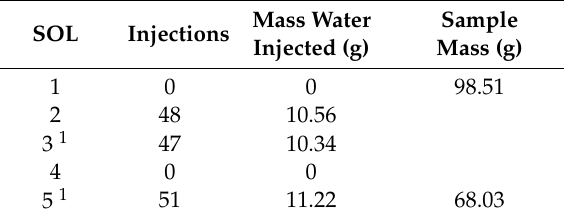
Table 5. Summary of the injection process in the 0